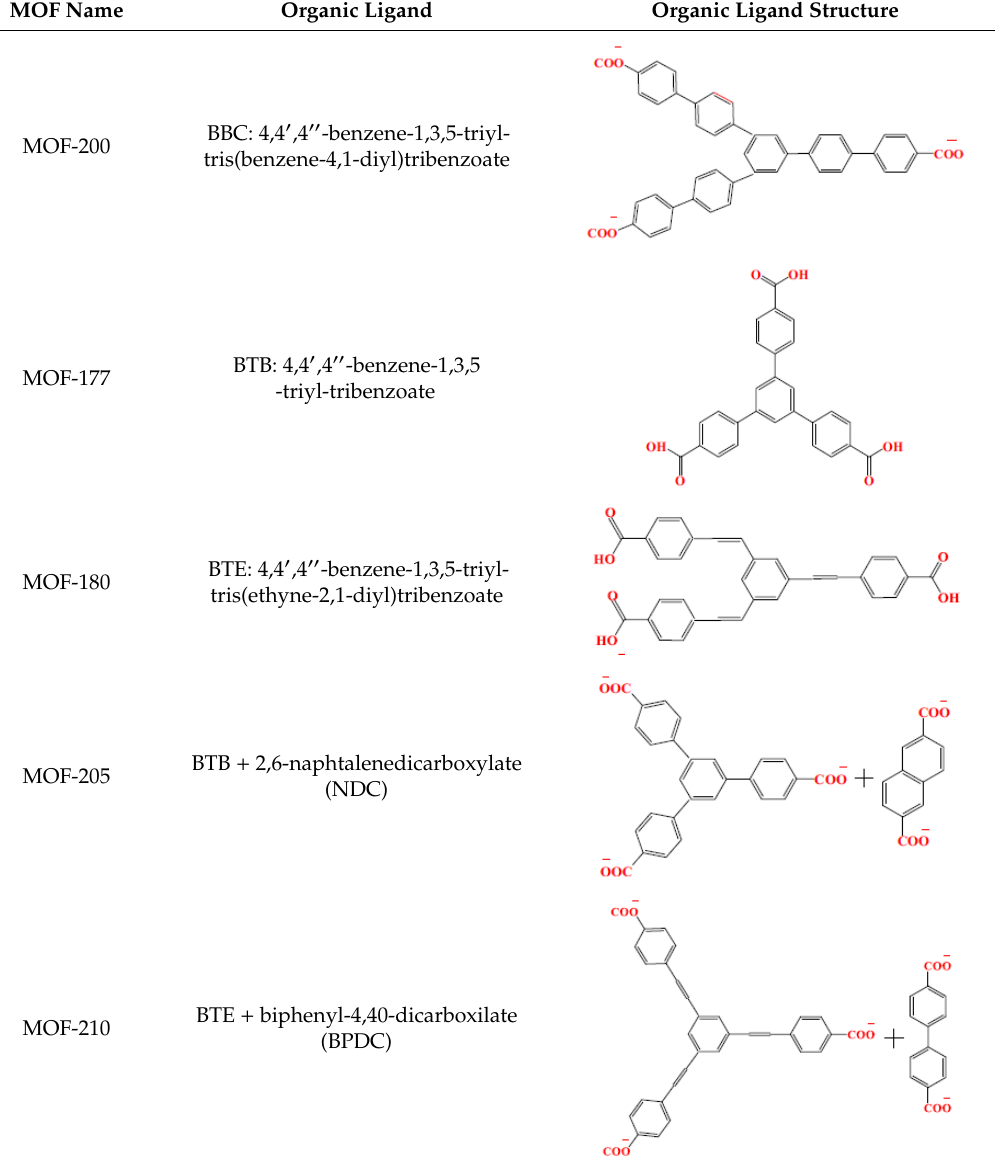
Figure 2. Schematic diagram of selective gas adsorption in Cu-BTC MOF (copper benzene-1,3,5- tricarboxylate) based on molecular sieving effect.